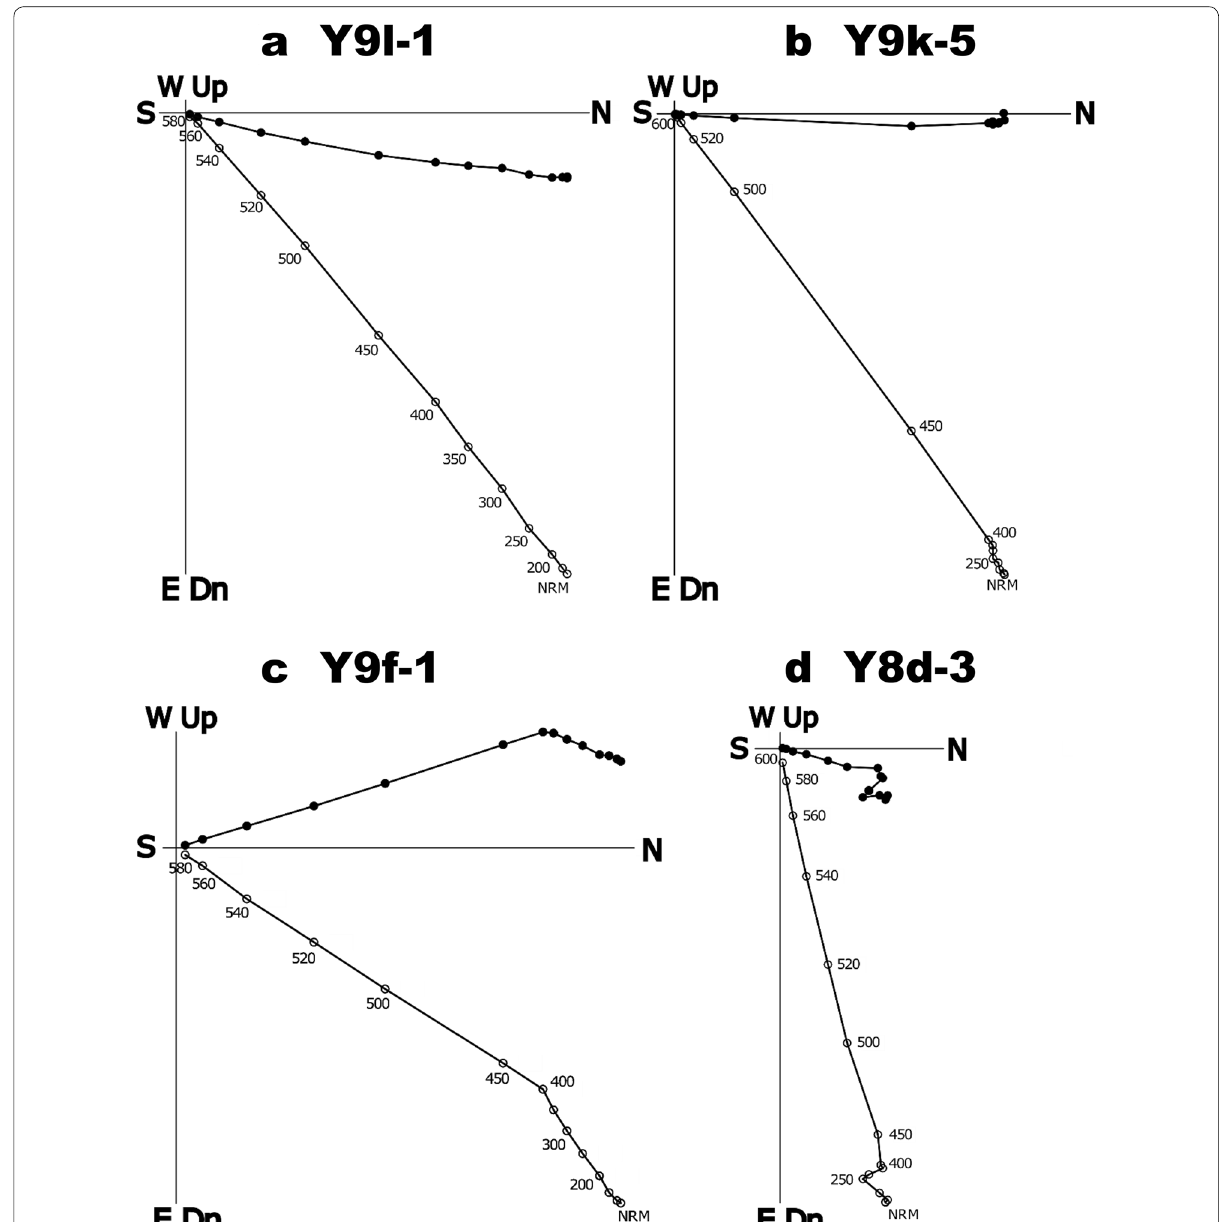
Fig. 3 Typical Zijderveld plots for PThD experiments. Solid and open circles, respectively, denote the horizontal and vertical projection. a One magnetic component with smooth decay to the origin. b Two magnetic components with a small low-temperature component. c Two magnetic components with a steady low-temperature component. d Multi-magnetic